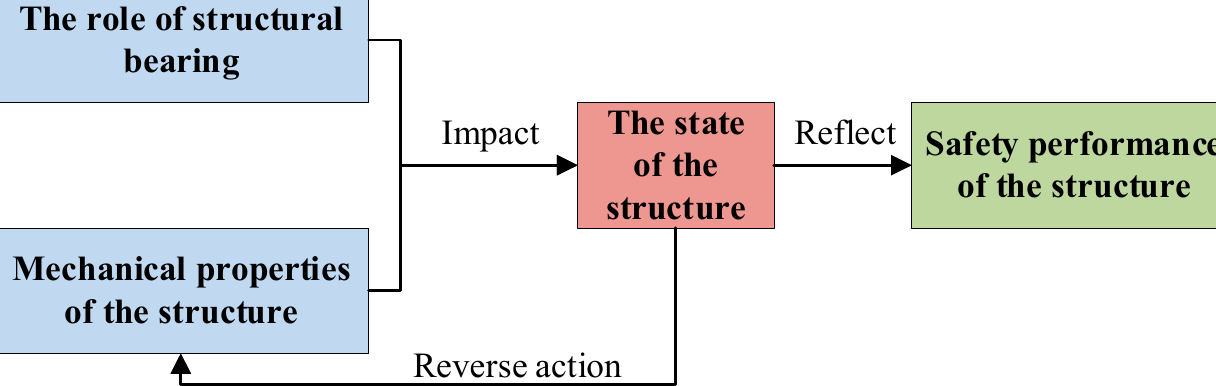
Figure 1. Intrinsic relationship of basic influencing factors of safety performance of prestressed steel structures during tensioning.